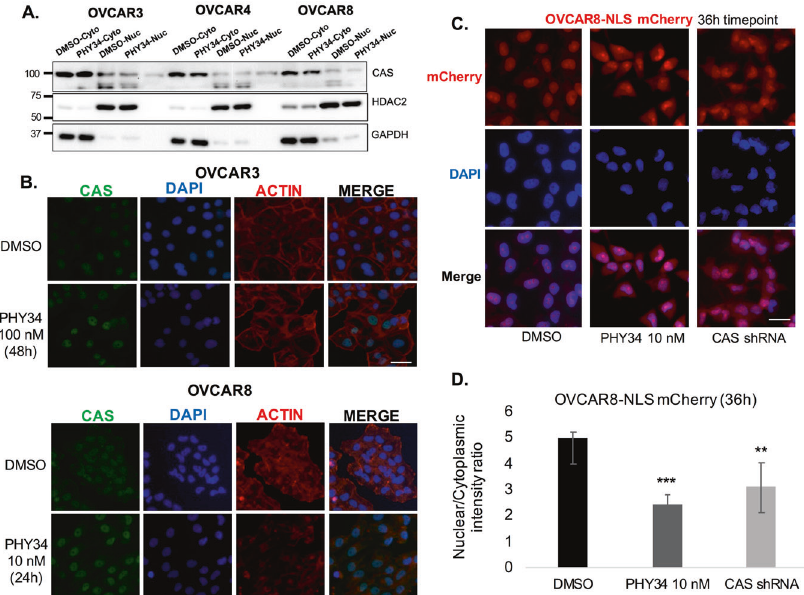
Fig. 5 PHY34 treatment and CAS knockdown leads to cargo mislocalization. A Representative immunoblots for CAS expression in OVCAR3, OVCAR4, and OVCAR8 cells using nuclear and cytoplasmic fractions of PHY34 treated cells. B Representative immuno fl uorescence images for CAS localization in OVCAR3, OVCAR4, and OVCAR8 cells treated with PHY34. DAPI and actin were used as nuclear and cytoplasm stains. Scale bar = 20 μ m. C Representative images of OVCAR8-NLS-mCherry cells treated with PHY34 (10 nM) and CAS shRNA lentivirus at 36 h timepoint. Scale bar = 20 μ m. D Nuclear and cytoplasmic intensities were quanti fi ed using ImageJ software (NIH). Ratios of the nuclear-to-cytoplasmic intensity of PHY34 treated (10 nM) and CAS shRNA samples were analyzed with unpaired t -test to vehicle control. ** p < 0.01, *** p <